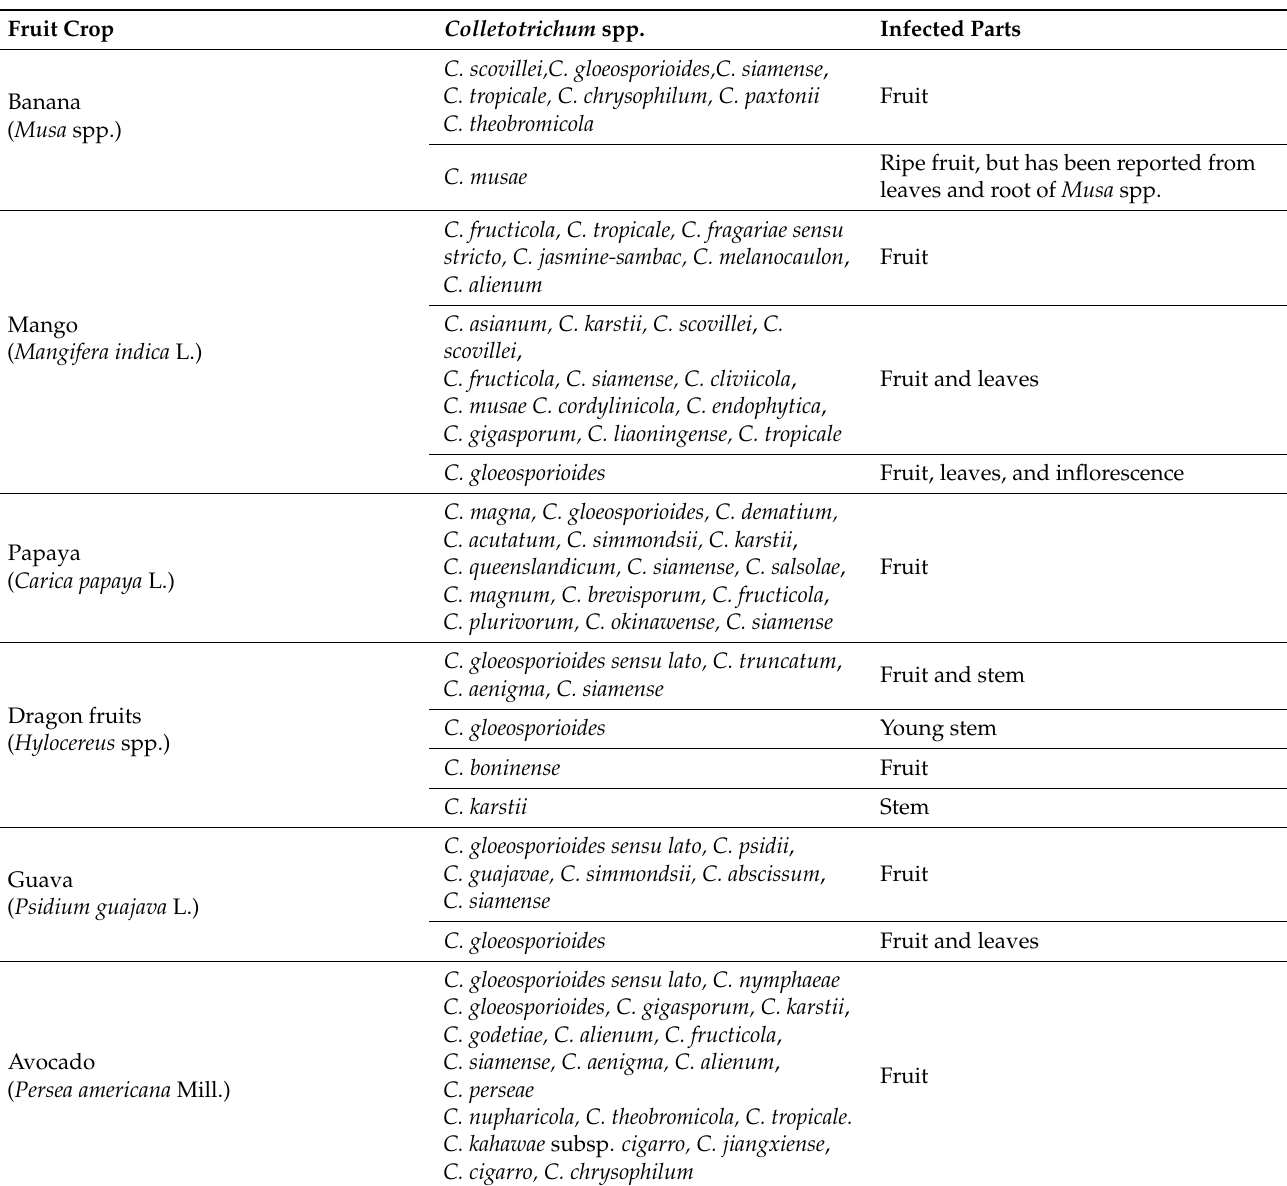
Table 2. Diversity of Colletotrichum spp. and the infected plant